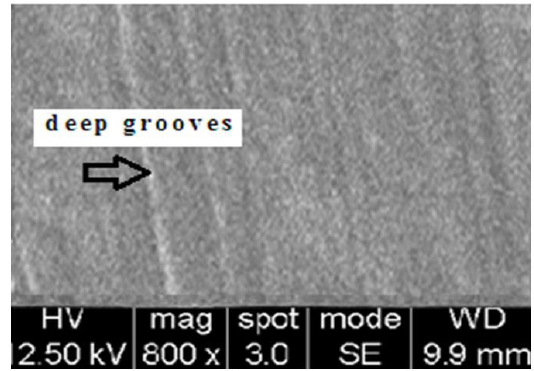
Figure 12. Surface of the material after EDM.